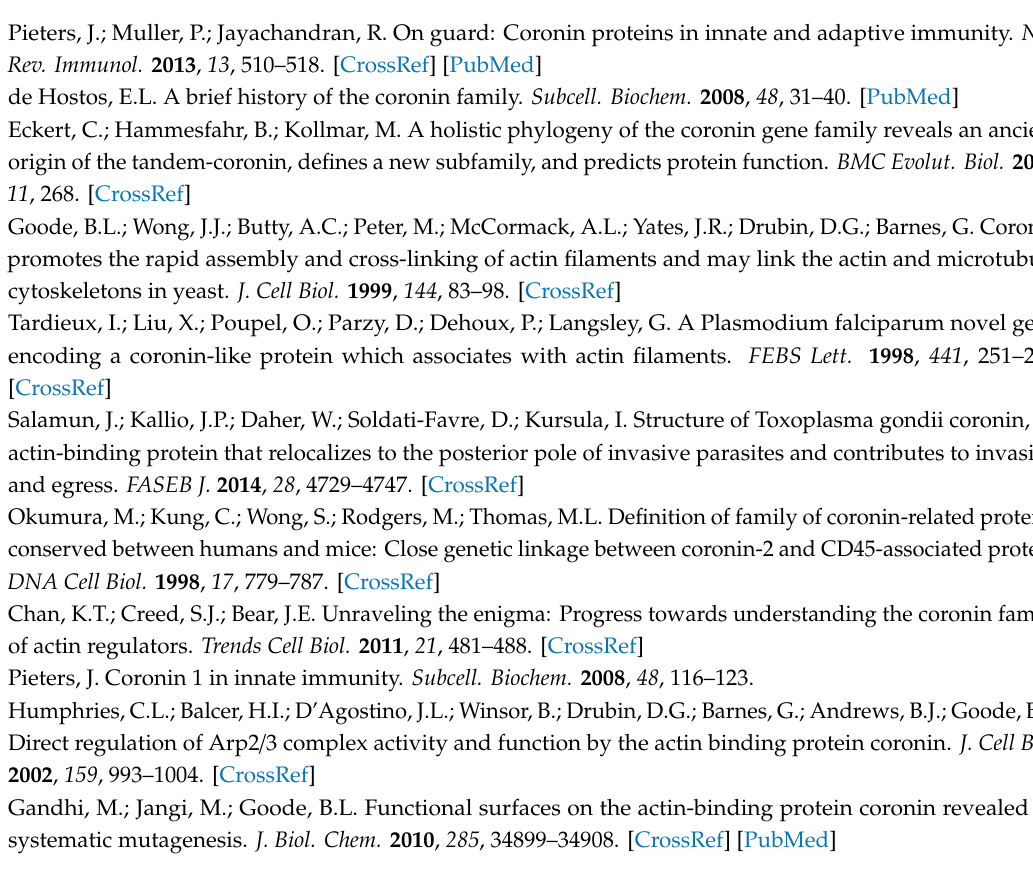
s1. Figure S1: Control for phagocytosis, Table S1: Table S1_Summary Sheet for all time points plus the combined, Table S2: